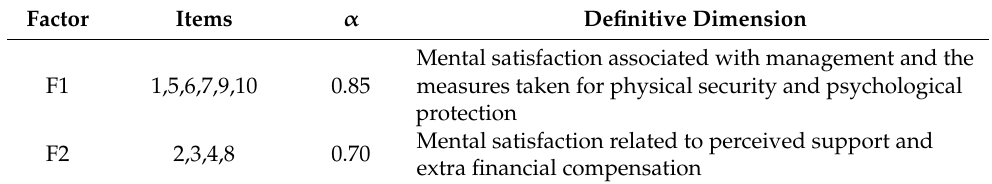
Table 11. Structure of the Satisfaction Scale after the EFA.